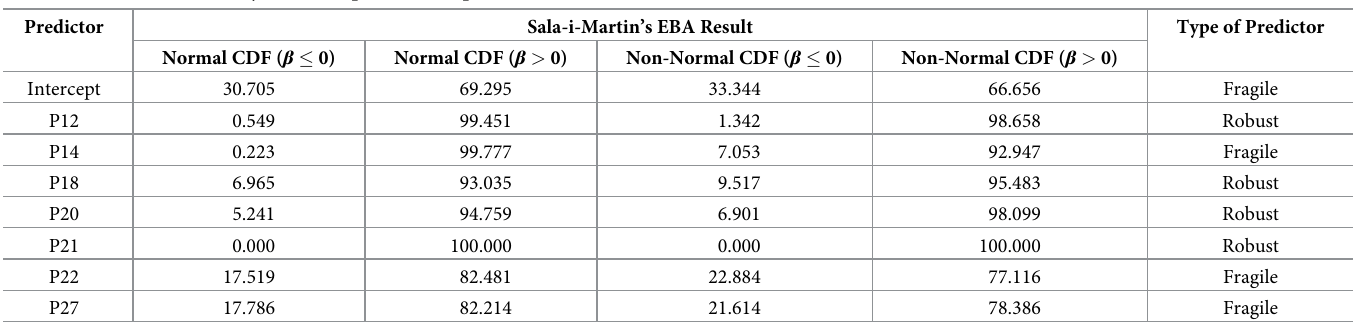
Table 11. Results of EBA analysis for cost performance